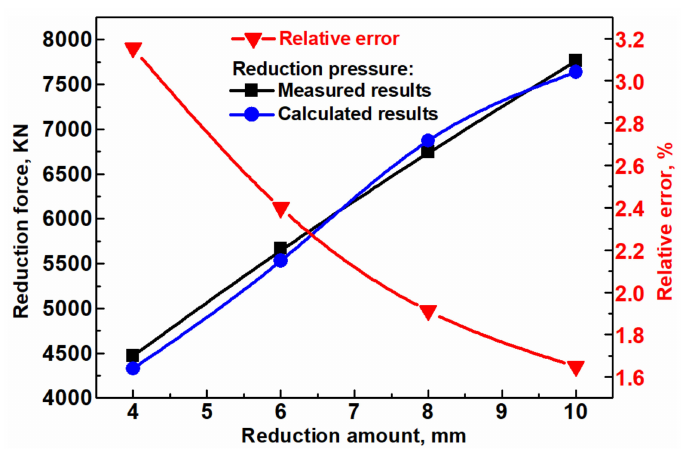
Figure 8. Comparison between the measured and the calculated reduction force.